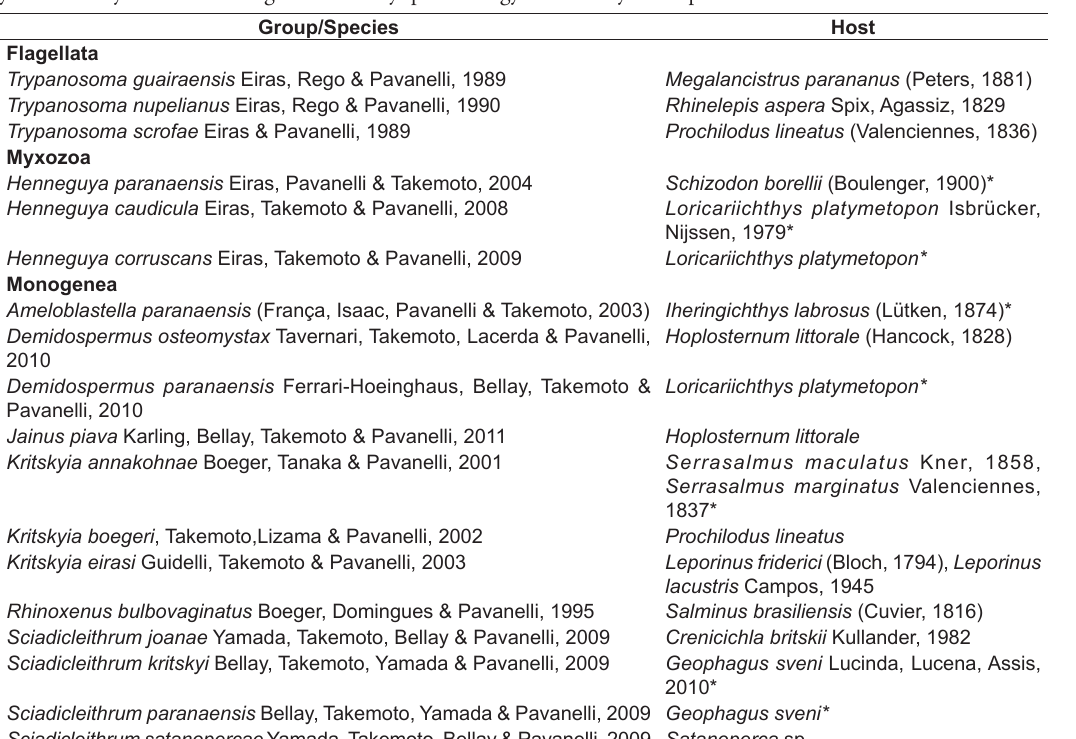
Table 1. Parasite species described in the upper Paraná River floodplain and their respective hosts, during the 37 years of study and monitoring in the Ichthyoparasitology Laboratory of